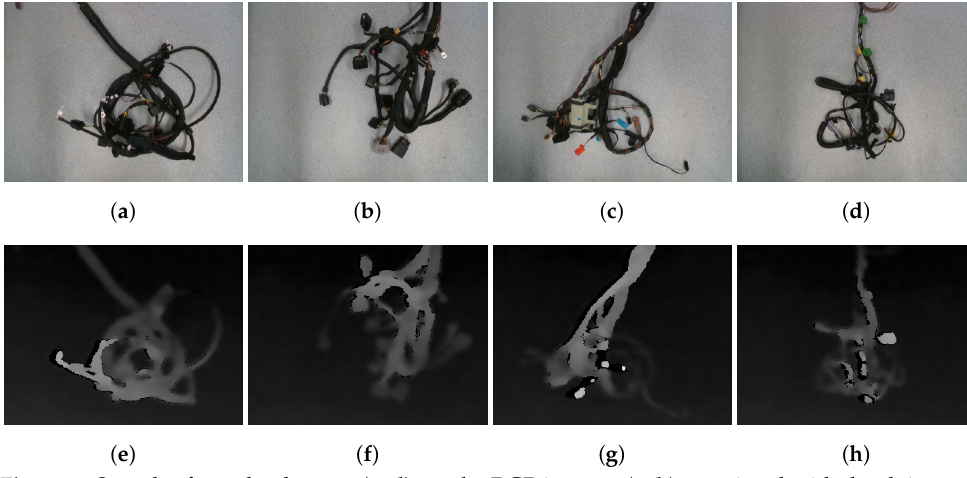
Figure 3. Samples from the dataset: ( a – d ) are the RGB images, ( e – h ) associated with depth images. Each pair comes from the different class: ( a , e ) branch 1, ( b , f ) branch 2, ( c , g ) branch 3, ( d , h ) branch 4.